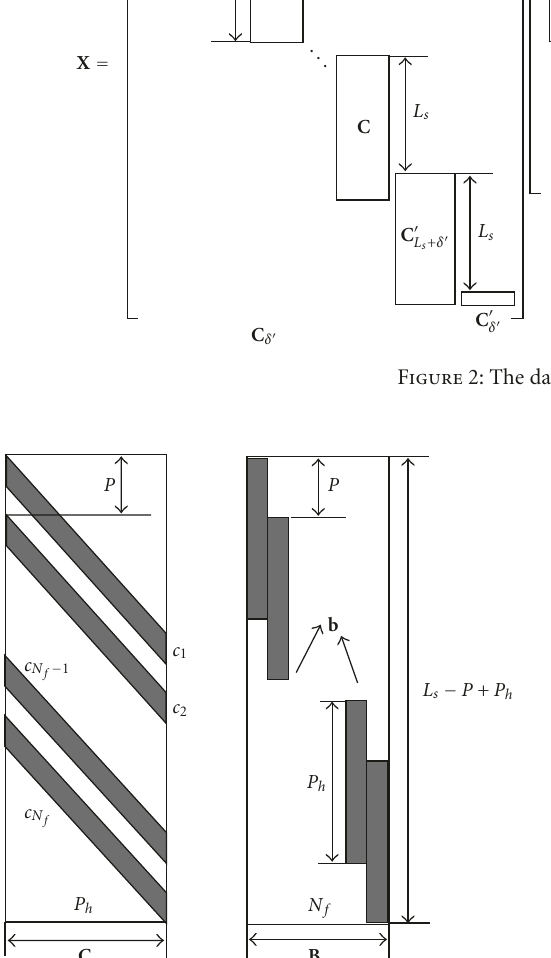
Figure 3: The structure of the code matrix C and the bias matrix B .